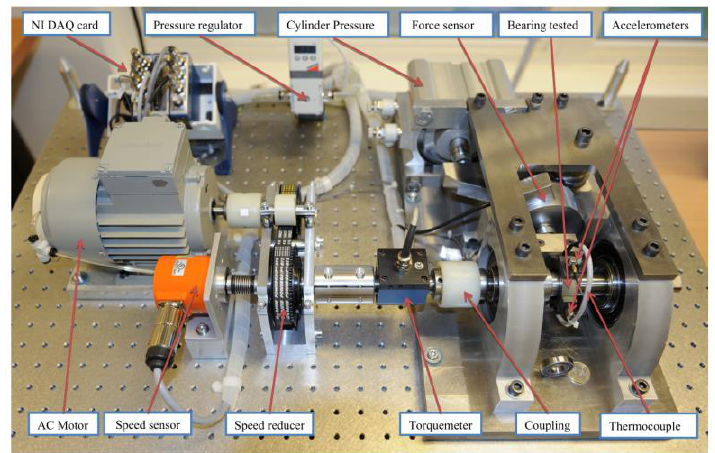
Figure 6. Overview of PRONOSTIA. Table 1. Three working conditions of the PHM2012